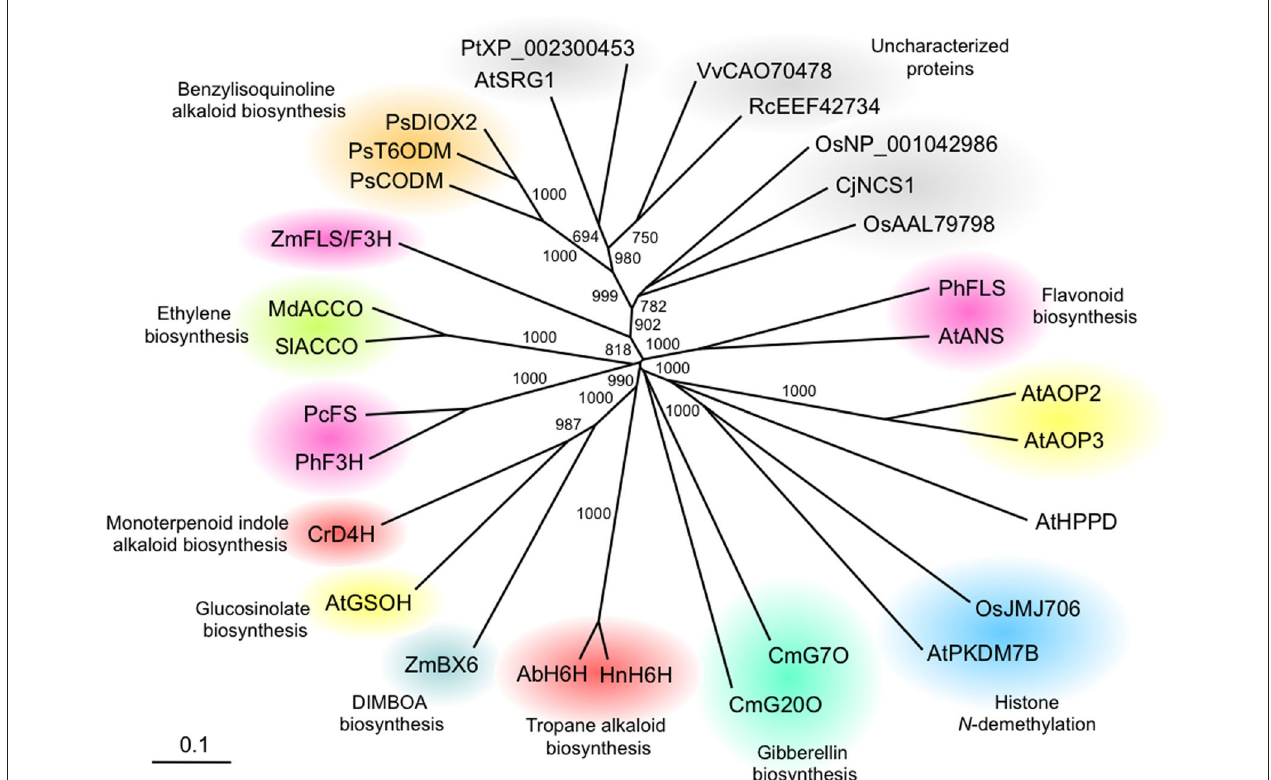
FIgure 2 | unrooted neighbor-joining phylogenetic tree for selected plant 2-oxoglutarate (2Og)/Fe(II)-dependent dioxygenases. Bootstrap frequencies for each clade represent values relative to 1000 iterations. Phylogeny and amino acid alignments were performed using ClustalX, and phylogenetic data were displayed using TREEVIEW (Page, 1996). Protein functional categories are shown in color. Species and associated GenBank accession numbers are as follows: Arabidopsis thaliana anthocyanidin synthase AtANS (Q96323); Arabidopsis thaliana AtAOP2 (AAL14646); Arabidopsis thaliana AtAOP3 (AAL14647); Arabidopsis thaliana putative but-3-enyl hydroxylase AtGSOH (NP_180115); Arabidopsis thaliana H3K4 N -demethylase AtPKDM7B (AAQ65171); Arabidopsis thaliana 4-hydroxyphenylpyruvate dioxygenase At4HPPD (AAB58404); Arabidopsis thaliana senescence-related gene 1 AtSRG1 (NP_173145); Atropa belladonna hyoscyamine 6 β -hydroxylaseAbH6H (BAA78340); Catharanthus roseus desacetoxyvindoline 4-hydroxylase